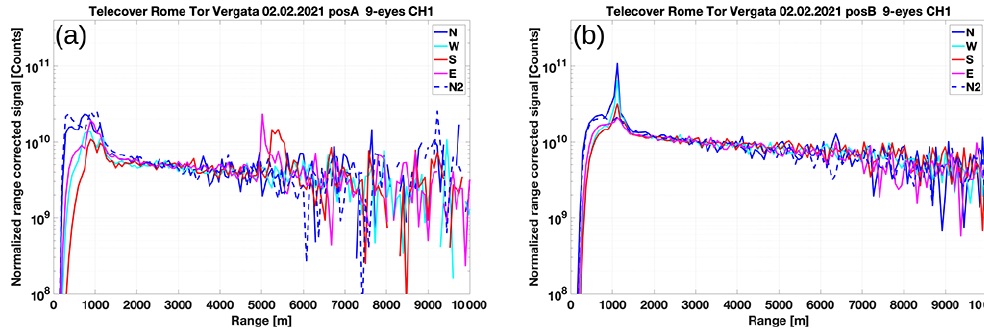
Figure 16. Telecover test results for the positions selected with manual (a) and mapping-based (b) alignment procedures.